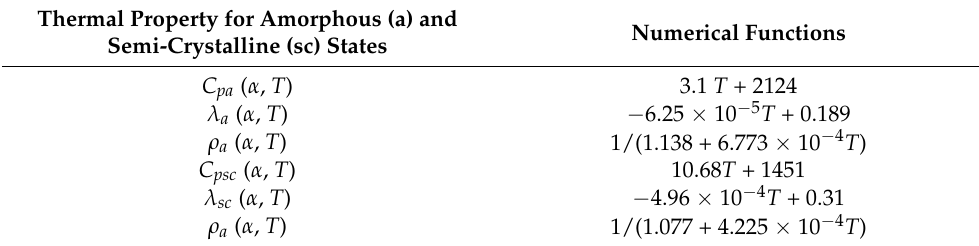
Table 2. Material properties of PP [36]. Reprinted with permission from [36]. Copyright 2005 Le Go.ff